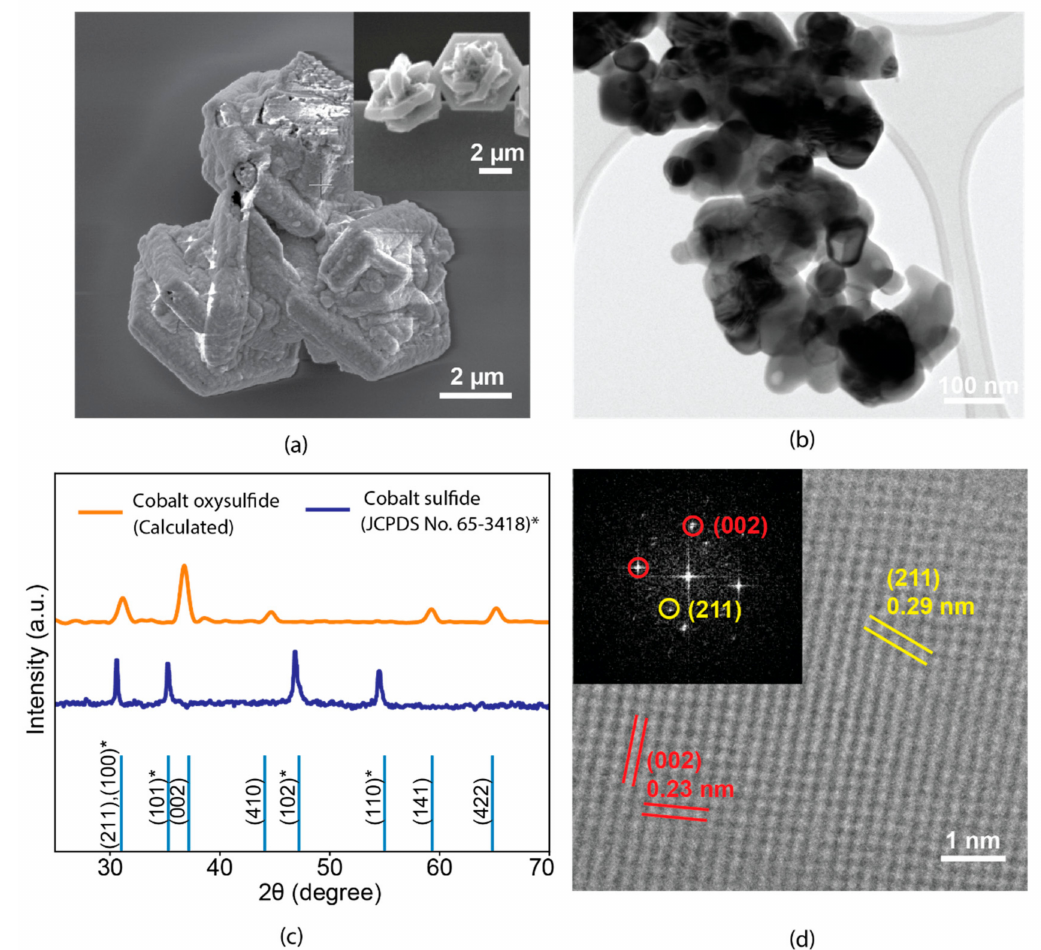
Figure 1. Morphology and crystal lattice structure for cobalt oxysulfide in ( a ) SEM and ( b ) low resolution TEM, ( c ) XRD (planes marked with black star ‘*’ belong to cobalt sulfide (JCPDS No. 65-3418)), and ( d )